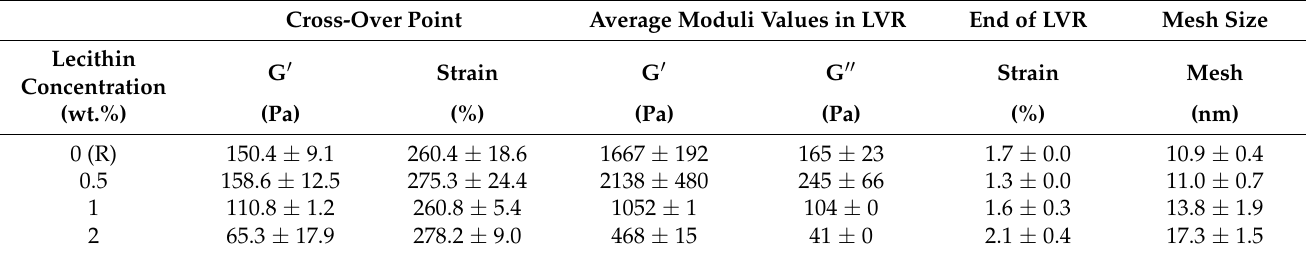
Table 4. Values for ionically crosslinked alginate hydrogels after preparation obtained from strain and frequency sweep tests before